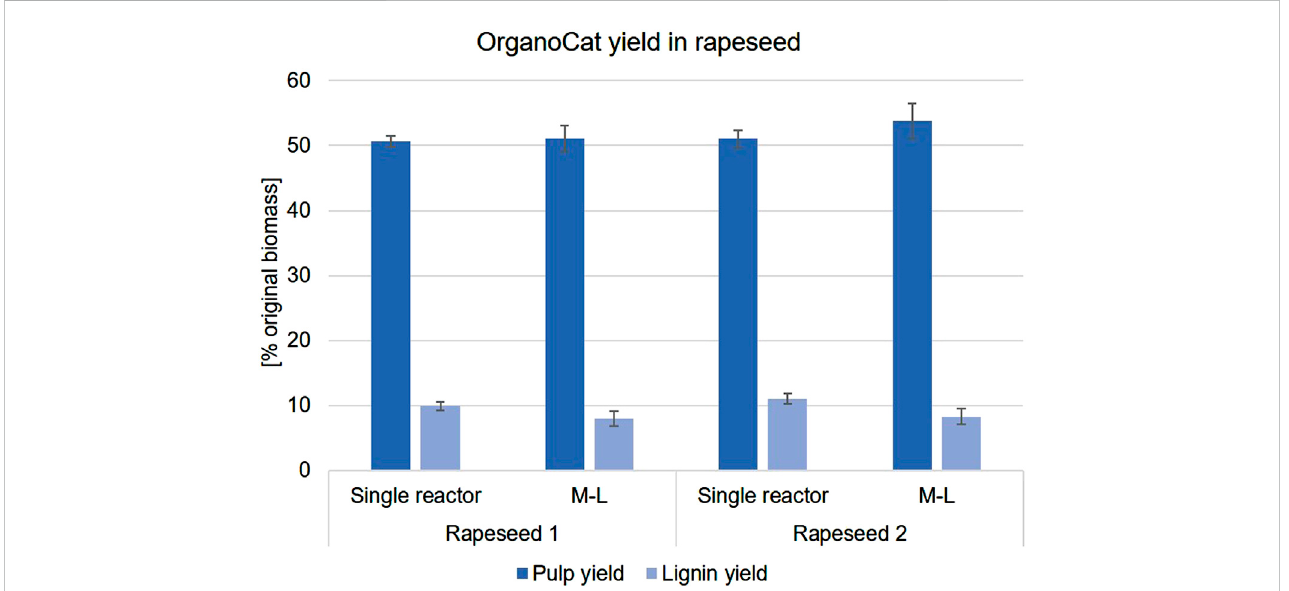
FIGURE 2 Pulp and lignin yield of Rapeseed 1 and 2 in a standard reactor and M-L modalities. Both systems were performed at 140 ° C for 3 h. For the standard reactor ( n = 10), pulpyield wasobtained by fi lter method, whereas pulp yield from themicroscale system ( n = 19)was obtained bydrying method.Lignin yield for both systems was obtained by evaporating the organic phase and weighing the remaining